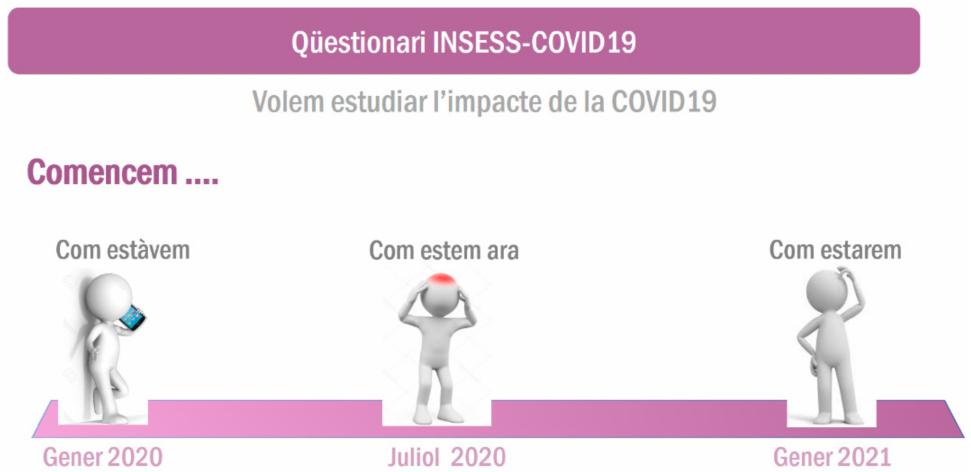
Figure 2. The three fixed time-stamps of the INSESS-COVID19